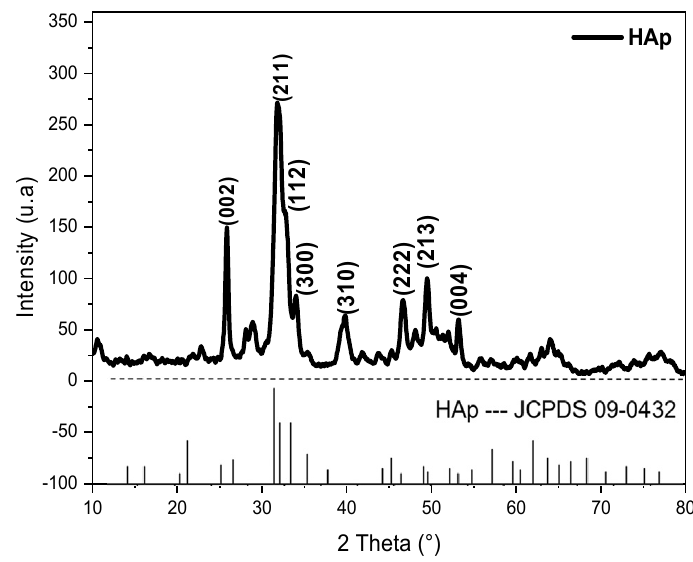
Figure 2. X-ray diffraction pattern of the synthesized HAp particles.